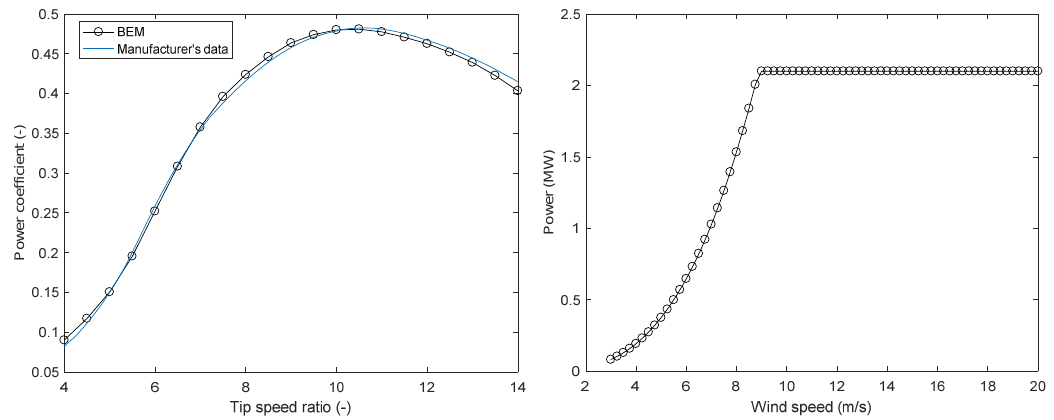
Figure 2. Comparison between the power coefficient and power curves obtained by blade element momentum (BEM) code and wind turbine manufacturer’s data.